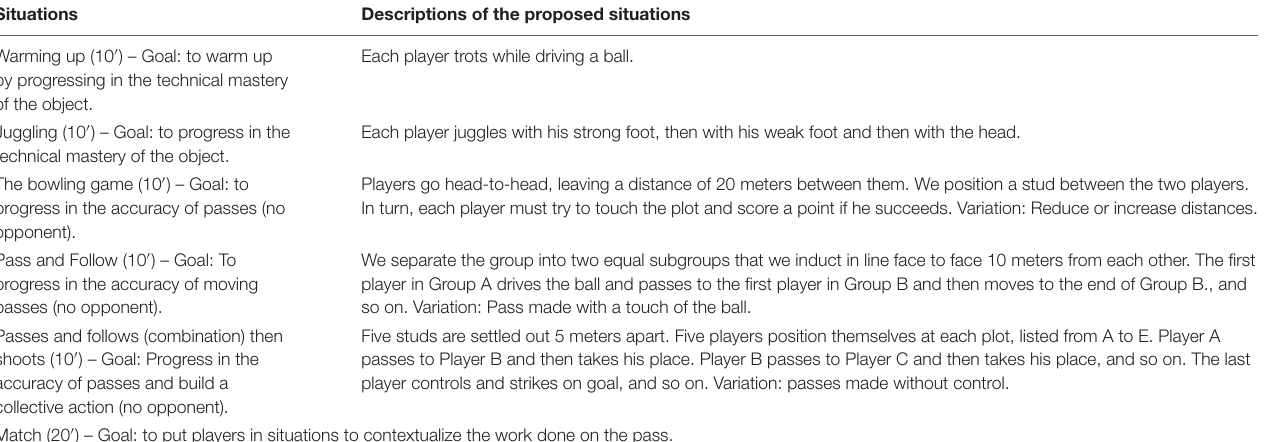
TABLE 2 | Description of situations offered to players aged 8–9 during a traditional (technical–tactical) training session on the topic of the pass. Situations Descriptions of the proposed